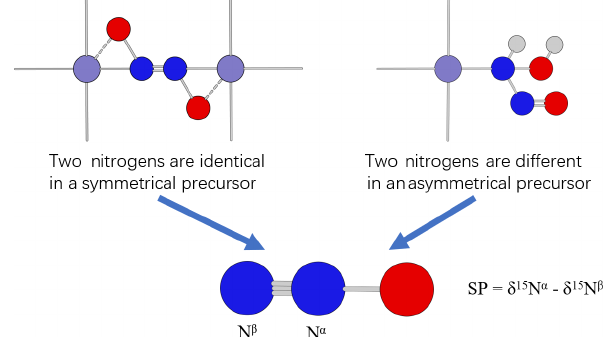
Figure 2. Proposed mechanisms for N 2 O formation from symmet- rical and asymmetrical precursors (modified from Schmidt et al., 2004). Light gray, red, blue, and purple spheres represent hydrogen, oxygen, nitrogen, and iron atoms,